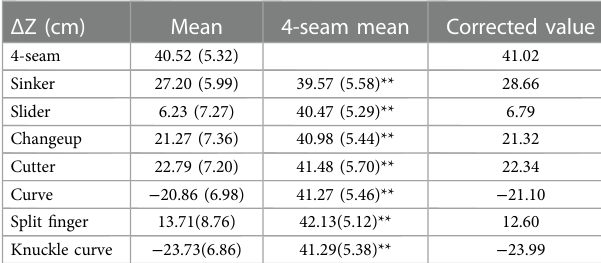
seam, and curve, knuckle curve, slider, split fi nger, and cutter were lower than 4-seam. Curve and knuckle curve were higher than 4-seam. Changeup and sinker were posterior than 4-seam.